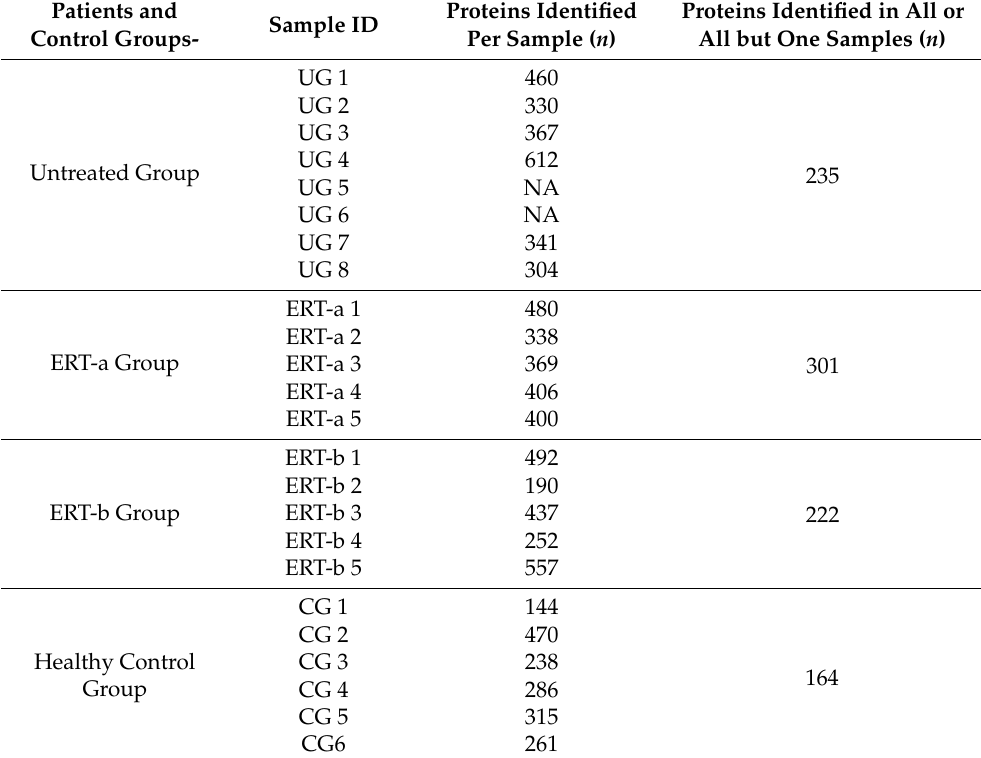
Table 2. Number of proteins per sample and number of common proteins per group. Only proteins with FDR < 1% were selected.